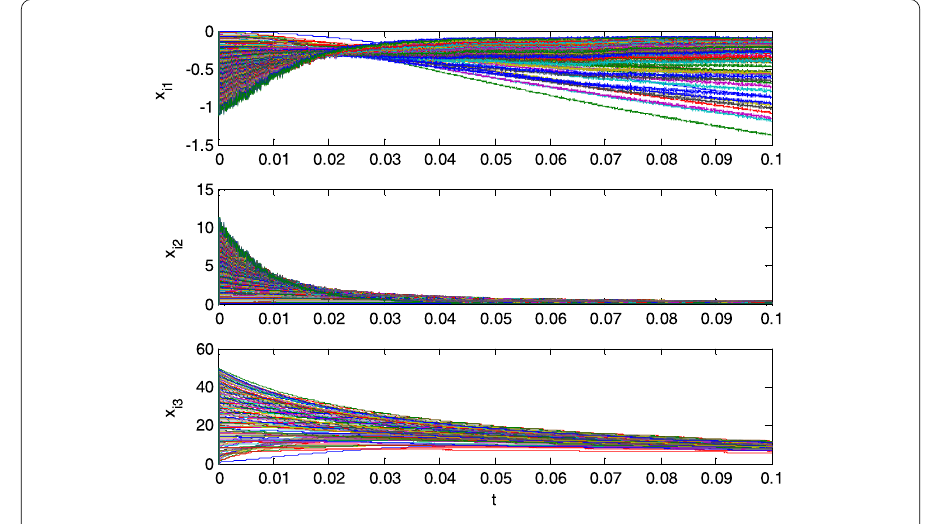
Figure 1 Trajectories of G 1 without controller